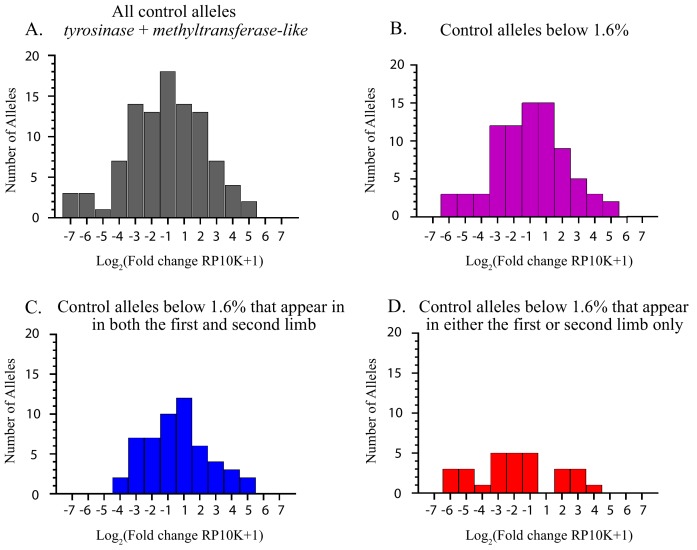
Histograms depicting the log of fold change after regeneration for alleles detected in the controls (methyltransferase-like and tyrosinase).(A) All alleles detected in the controls. (B) All alleles that occur with a mutation frequency of 1.60% or less. The majority of these alleles undergo less than a two-fold change after regeneration. (C) All alleles that occur with a mutation frequency of 1.60% or less and are preserved between the first and second limb. (D) All alleles with a mutation frequency less than 1.60% that occur in either the first limb or the second limb only.